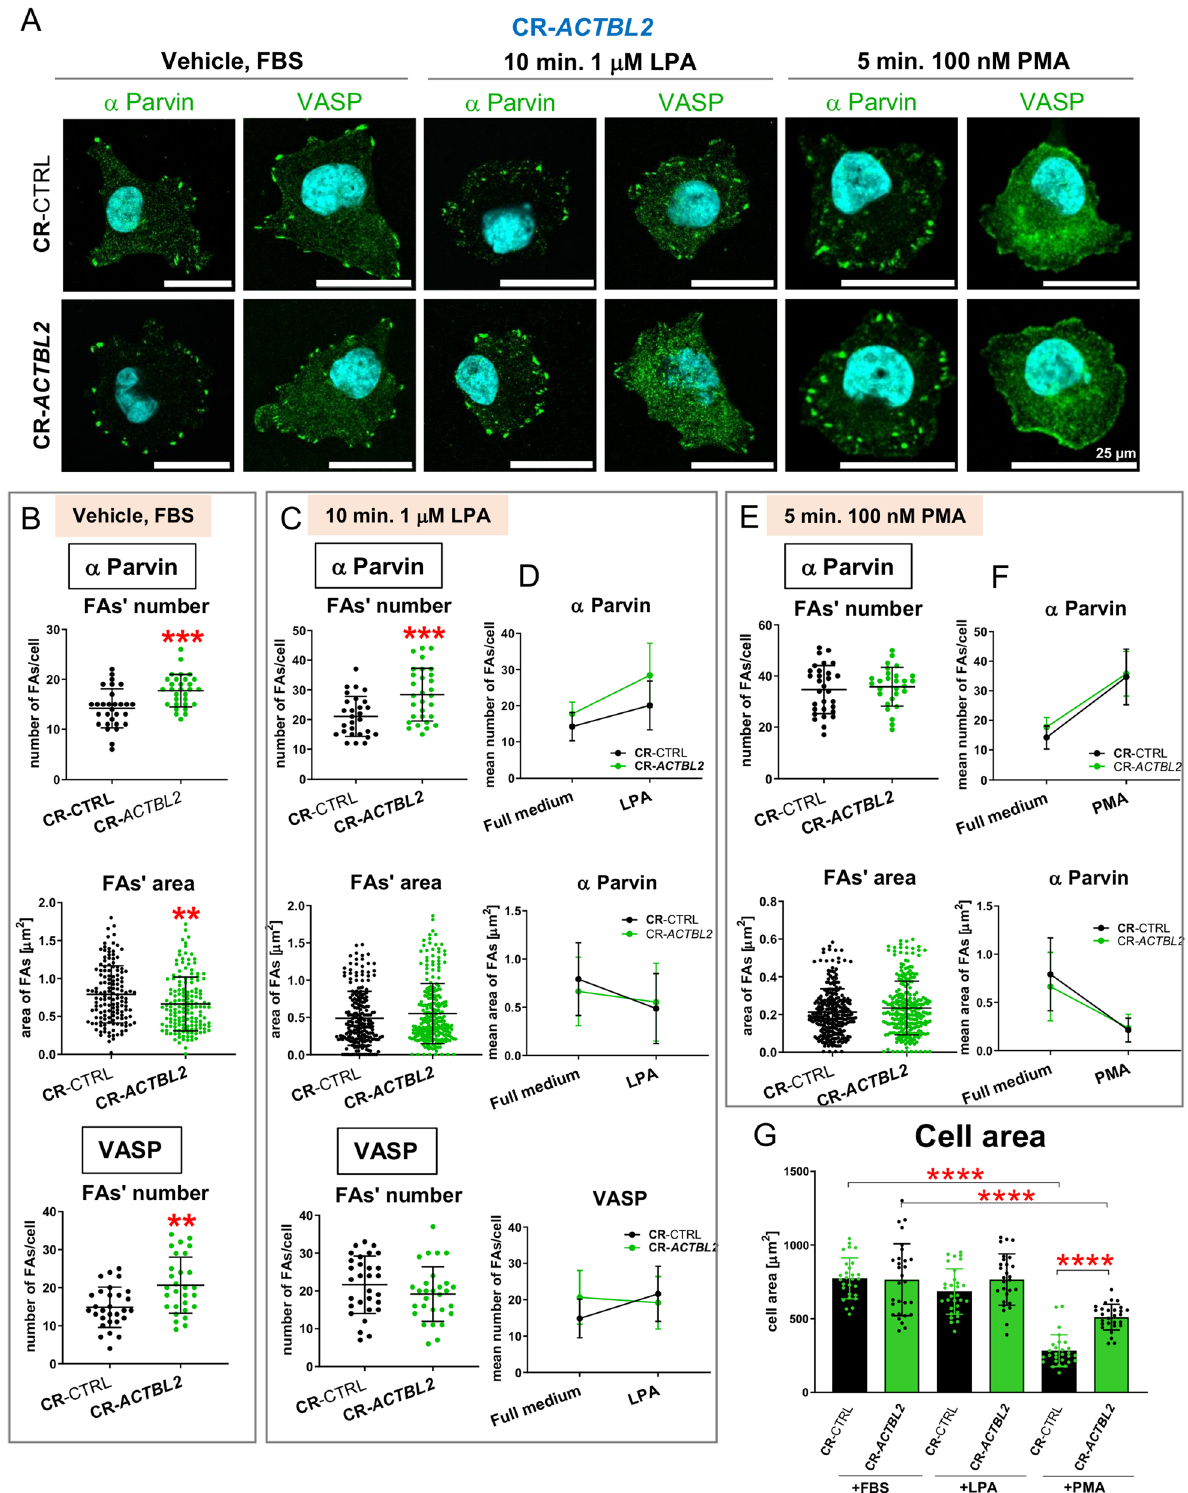
Figure 10. The formation of focal adhesions is changed in CR- ACTBL2 cells relative to CR-CTRL clones. ( A ) The cells were seeded on coverslips. Some of them were treated with either 1 μM LPA for 10 min or 100 nM PMA for 5 min. 24 h later, they were fixed. The cells were stained with antibodies recognizing either α-Parvin or VASP. ( B , C , E ) Based on captured photos, the number of FAs and their area were estimated (n = 30). ( D , F ) Slope graphs presenting trends upon LPA or PMA stimulation in the number and surface area of FAs. ( G ) The cell area surface of the cells grown in the presence of FBS or treated with either LPA or PMA was measured (n = 30). Results are expressed as the mean ± SD; p ≤ 0.01 (**), p ≤ 0.001 (***), p ≤ 0.0001